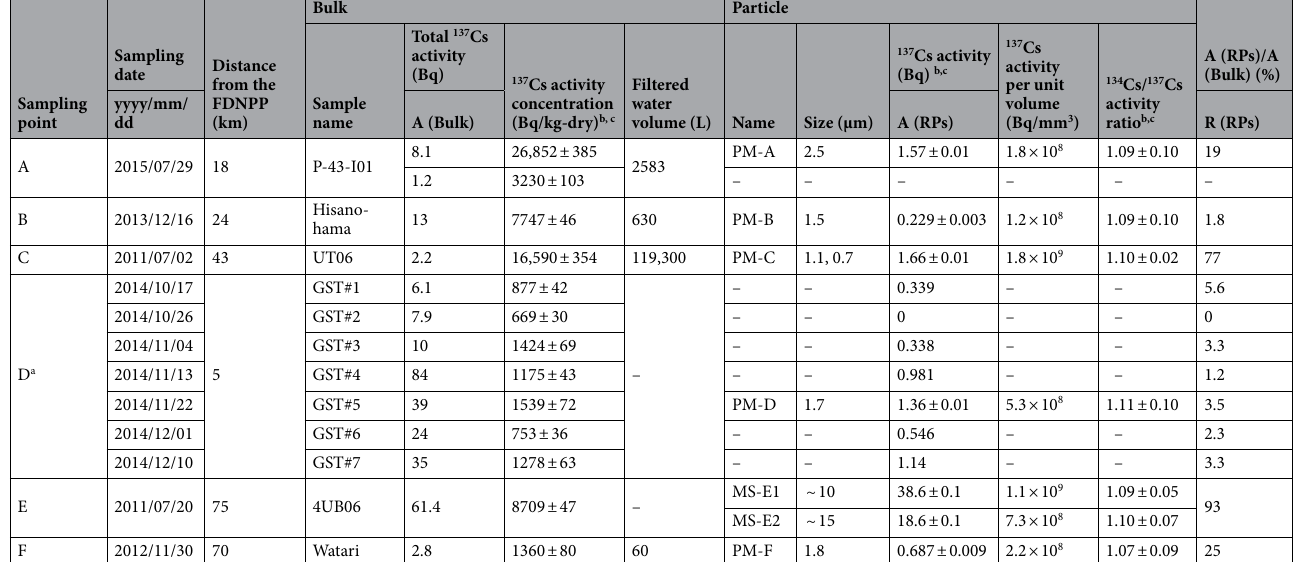
Table 1. Data for the bulk samples and the isolated radioactive particles (RPs). a At sampling point D, a RP was isolated only from GST#5; other A (RPs) values were calculated from the photo stimulated luminescence of the imaging plate images. b Values are decay-corrected to 11 March 2011. c The 1σ error is based on the counting